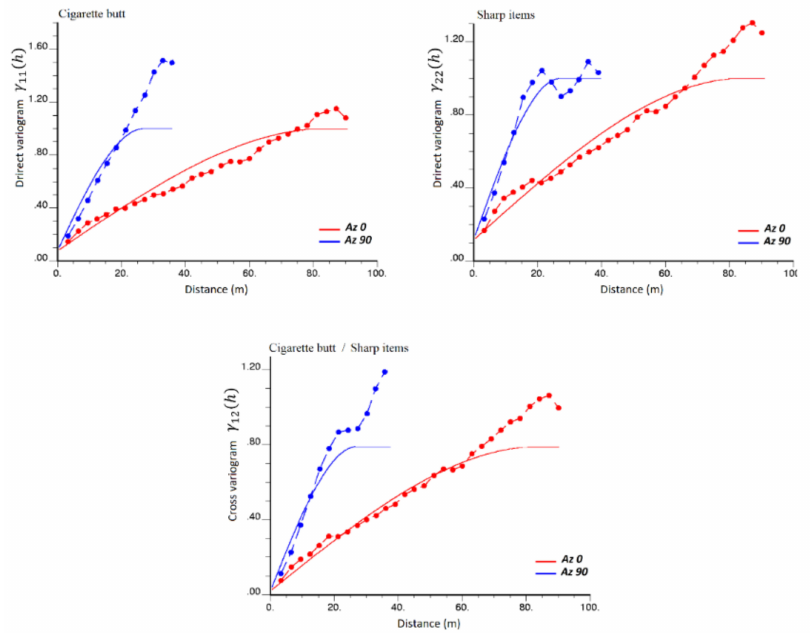
Figure 7. Experimental (dashed lines) and modeled (solid lines) variograms of the normal scores data along two mains anisotropy directions, Az 0 ◦ (Red) and Az 90 ◦ (Blue). Top: direct variograms. Bottom: